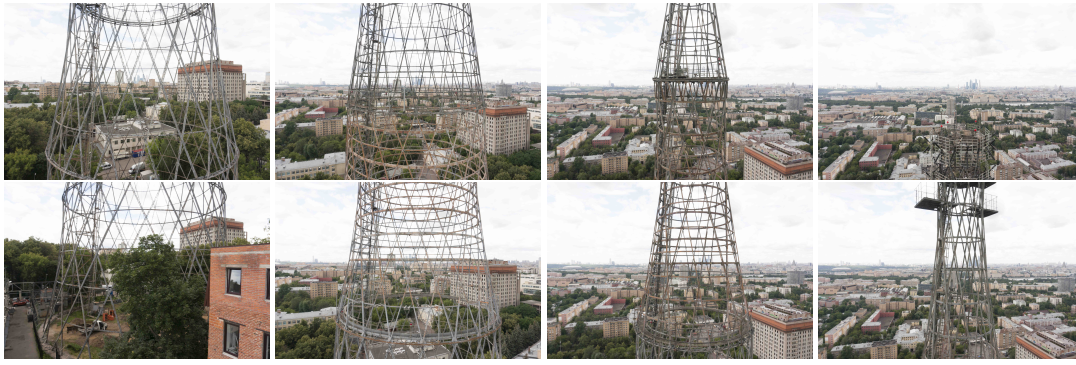
Figure 2. Samples from image